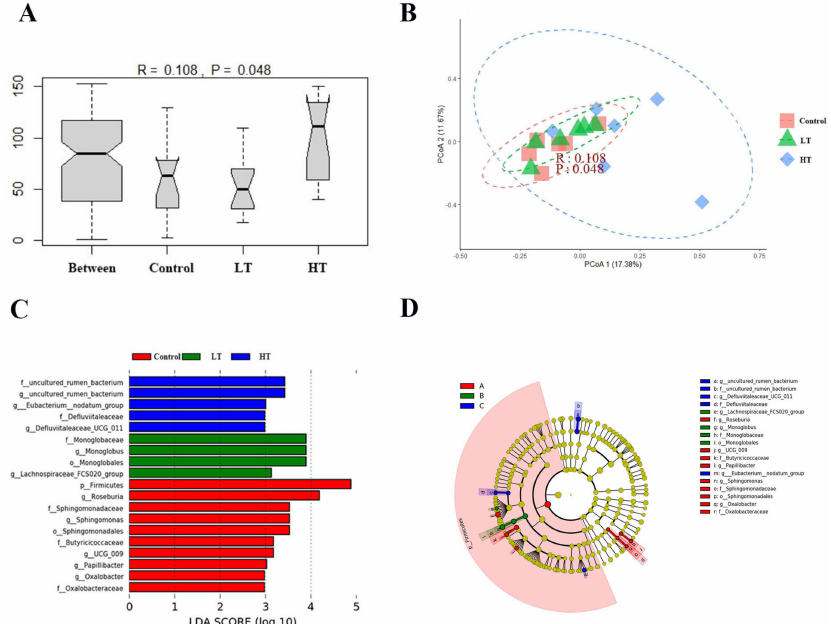
Figure 5. Effect of TA on the colonic microbial β -diversity and colonic microbial biomarker abundance of Brandt’s voles. ( A ) ANOSIM analysis plot. ( B ) Principal coordinates analysis. ( C ) LDA distribution. ( D ) Cladogram. The threshold of LDA score was 2.0. Control, 0 mg • kg − 1 d − 1 TA; LT, 600 mg • kg − 1 d − 1